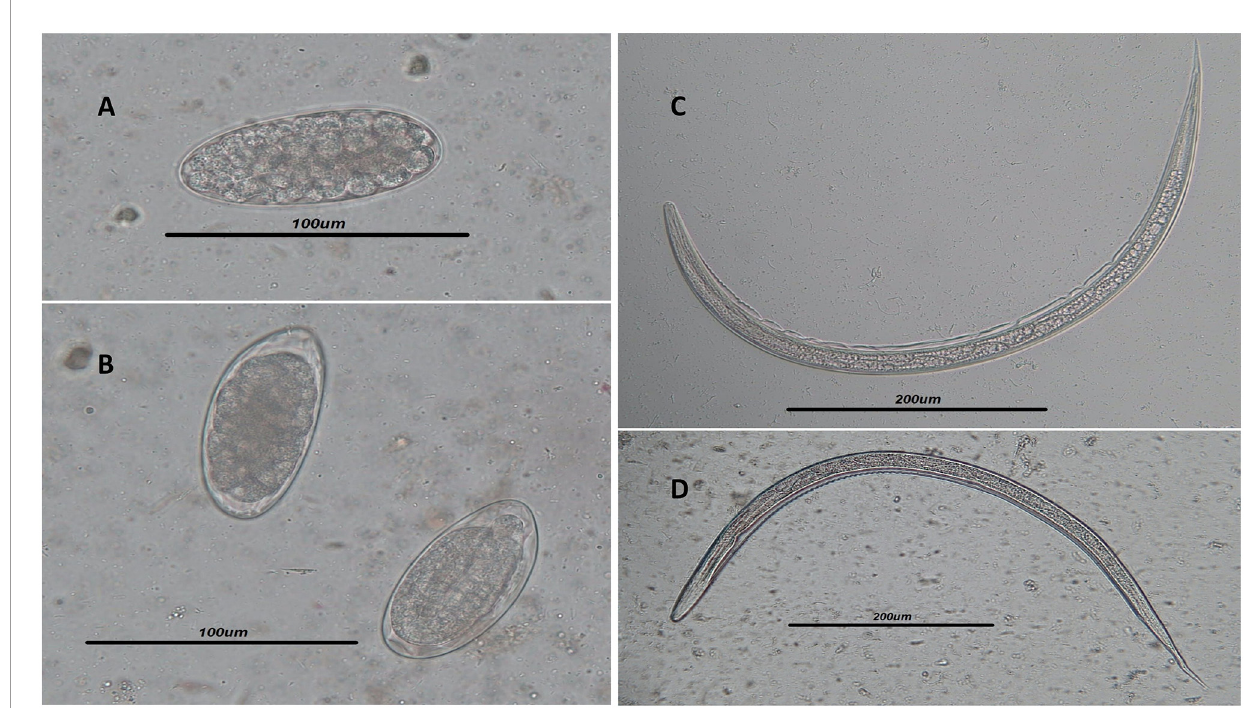
FIGURE 1 | (A, B) Light microscope view of Trichostrongylus spp. eggs isolated by the Willis technique in the stool samples of infected humans. Scale bar , 100 m m. (C, D) Filariform larvae of Trichostrongylus spp. isolated from agar plate culture. Scale bar , 200 m